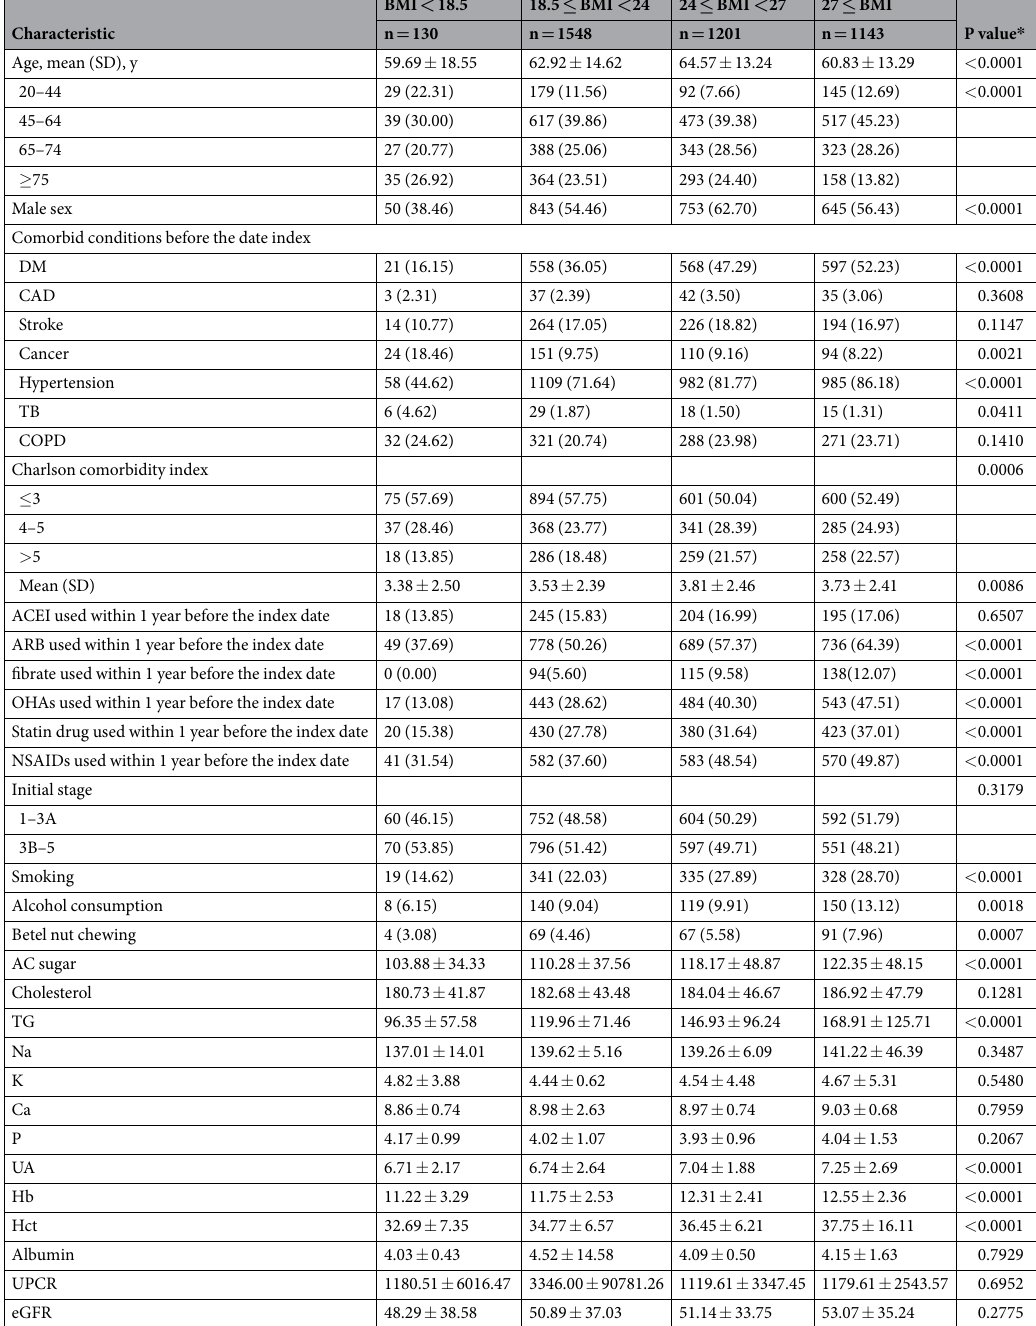
Table 1. Baseline characteristics of study cohort according to different BMI. * Categorical variables: chi-squared test; continuous variables: ANOVA. DM, diabetes mellitus; CAD, coronary artery disease; CKD; chronic kidney disease; OHA, oral hypoglycemic agents; TG, total glycerides; UA, urine albumin; Hb, hemoglobin; Hct, hematocrit; UPCR, urine protein-to-creatinine ratio; eGFR, estimated glomerular filtration